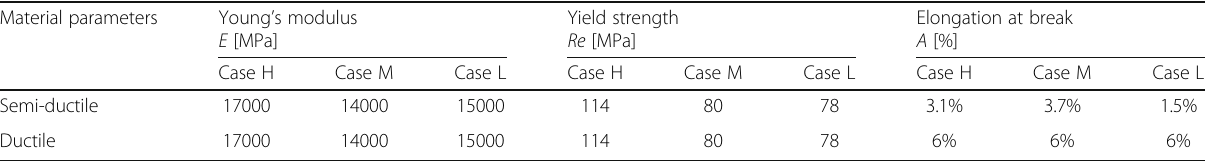
Table 4 Material parameters used for FKM approach Material parameters